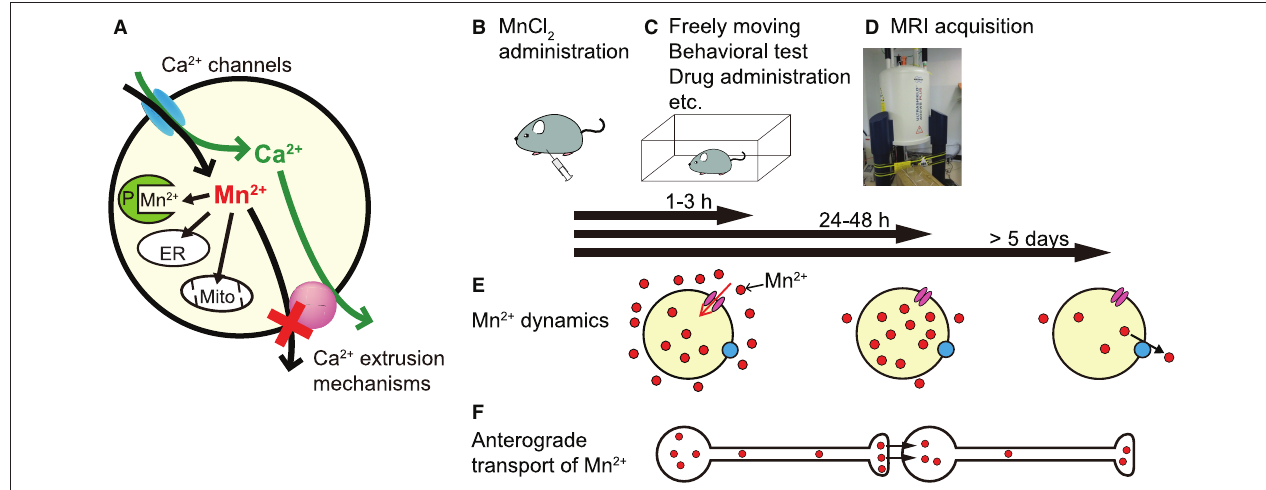
FIGURE 1 | The principle and experimental sequence of MEMRI and Mn 2 + dynamics in the brain. (A) Mn 2 + enters the cell through Ca 2 + channels and is difficult to extrude since it is incorporated in organelles, e.g., endoplasmic reticulum (ER) and mitochondria (Mito), and binds to various proteins (P). (B–D) An example experimental sequence of MEMRI (see text). (E) Mn 2 + dynamics in the brain. Extracellular Mn 2 + is increased rapidly within 1h, remains high for 3h (left), and returns to near control levels by 24h (middle) after intraperitoneal MnCl 2 injection. In the brain parenchyma, Mn 2 + increases slowly, peaks at 24–48h after administration (middle), and returns to control levels at 5 days (right) after a single administration. (F) Time course of the anterograde transport of Mn 2 + . The position of the transported Mn 2 + (red particles) is roughly aligned with the time bar above (E)